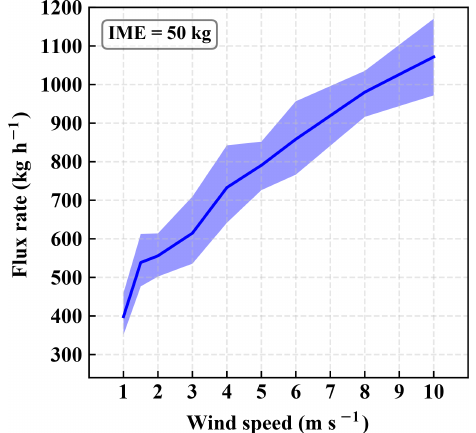
Figure 11. Relationship between flux rate and wind speed for 50kg IME. The shaded area represents 1 standard deviation from the mean flux rate at each given wind speed.